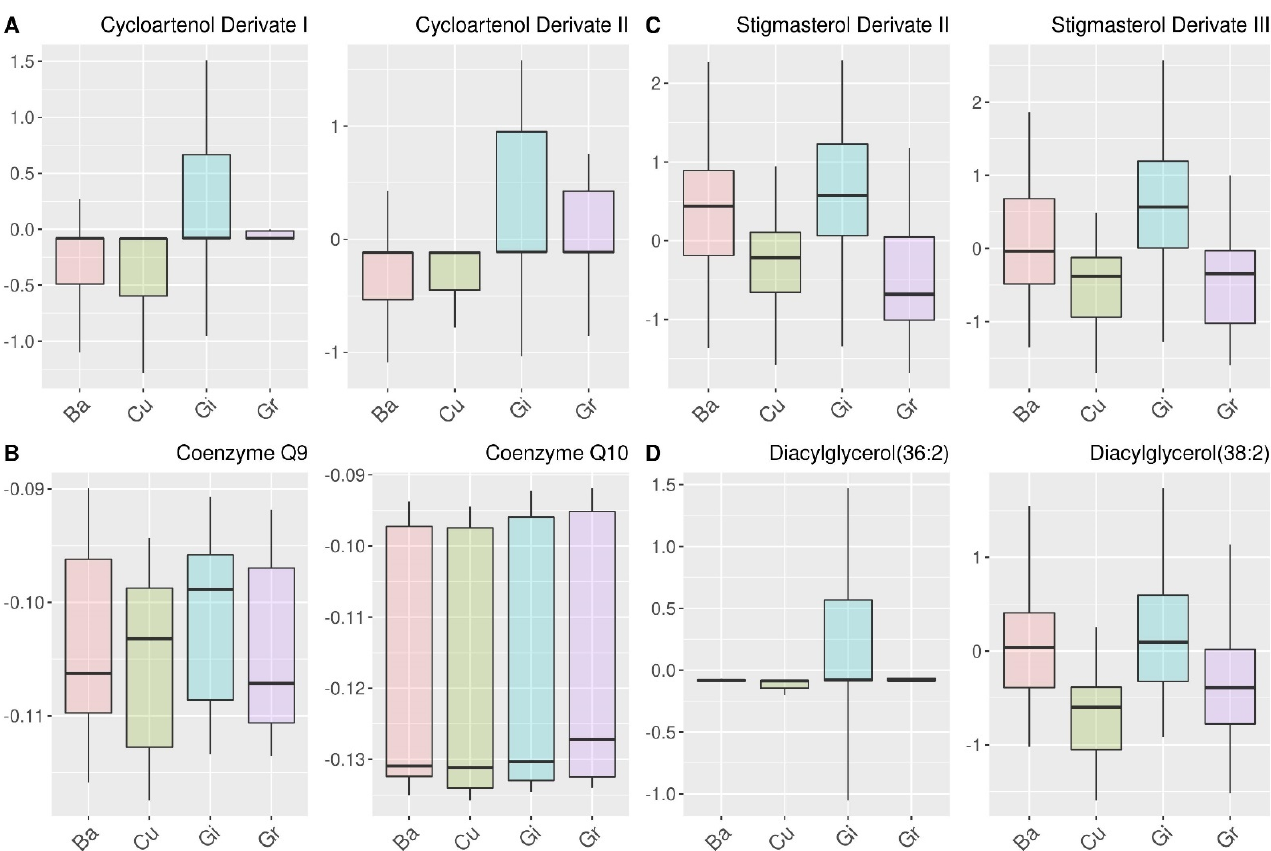
Figure 5. Boxplots of the autoscaled intensities for two exemplary features of the clusters ( A – D ) from the relation analysis for the determination of botanical variety in Figure 3B. Detailed information about the metabolites can be obtained from Table S7.